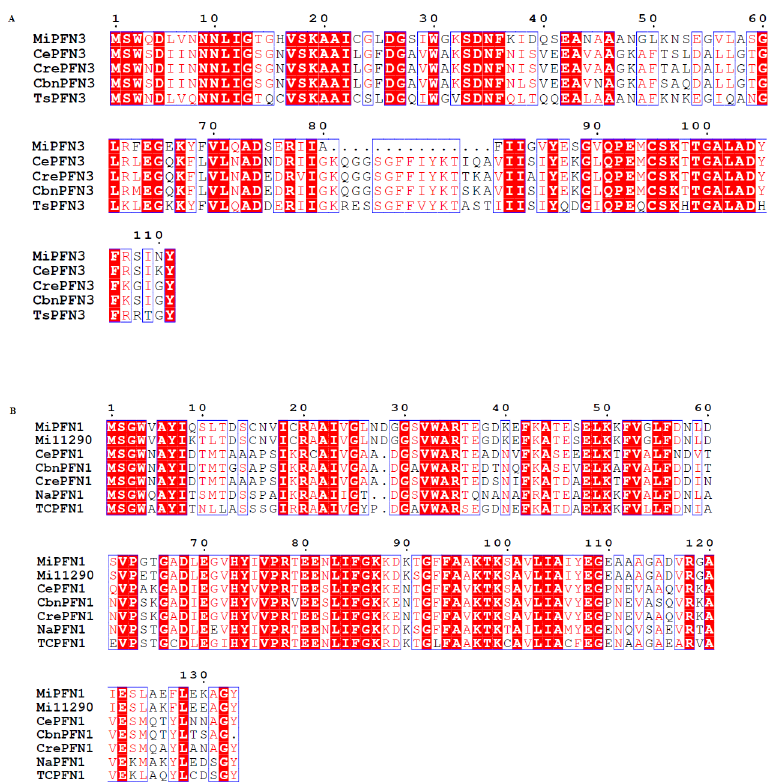
Fig 1. Multiple sequence alignment between two M . incognita profilins (MiPFN3 and MiPFN1) and their homologs in other nematodes. (A) Amino acid alignment of MiPFN3 with CePFN3, C . elegans PFN3 sequence K03E6.6; CrePFN3, Caenorhabditis remanei sequence CRE17080; CbnPFN3, Caenorhabditis brenneri sequence CBN01684; TsPFN3, Trichinella spiralis locus KRY72800. (B) Amino acid alignment of MiPFN1 with protein encoded by Minc11290, CePFN1, C . elegans sequence Y18D19.20; CrePFN1, Caenorhabditis remanei sequence CRE25828; CbnPFN1, Caenorhabditis brenneri sequence CBN24699; NaPFN1, Necator americanus sequence XP_013297957; TcPFN1, Toxocara canis sequence KHN75347. Strictly conserved residues are in white type on a red background; well- conserved residues are in red type, and conserved regions of residues are in blue boxes.